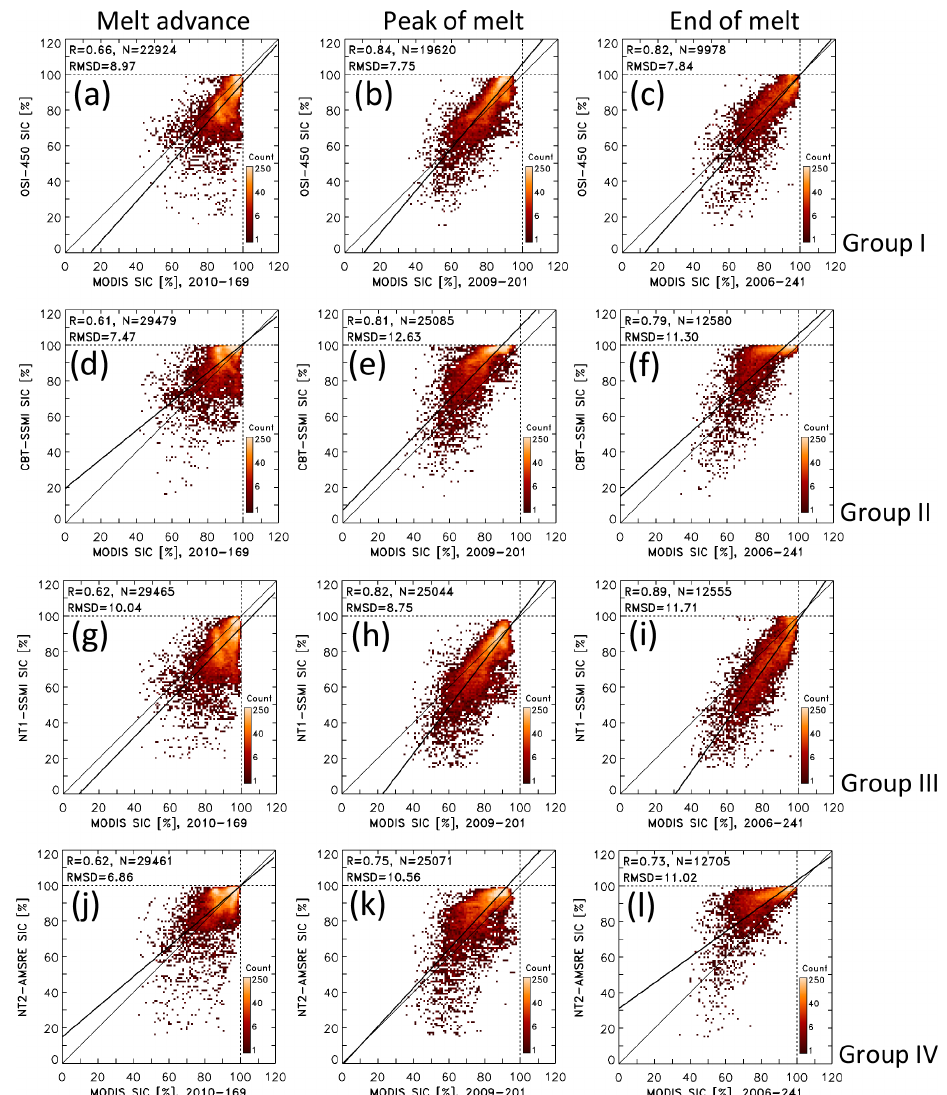
Figure 5. Two-dimensional histograms of the distribution of PMW ( y axis) versus MODIS ( x axis) SIC data pairs using a bin size of 1% for the same 8d periods as shown in Fig. 4e–p, i.e. melt advance, peak melt, and end of melt. The topmost row shows OSI-450 (for group I), the second row CBT-SSMI (for group II), the third row NT1-SSMI (for group III), and the bottommost row NT2-AMSR-E (group IV). The thin black line is the identity line. The thick black line denotes the linear regression through the data pairs. At the top left of every image we display the linear correlation coefficient R , the number of data pairs N , and the root-mean-squared difference RMSD; the latter is given in percent. The leftmost, middle, and rightmost columns represent melt advance, peak of melt, and end of the melt, respectively. Respective scatter plots for pre-melt are shown in Fig. S6 in the